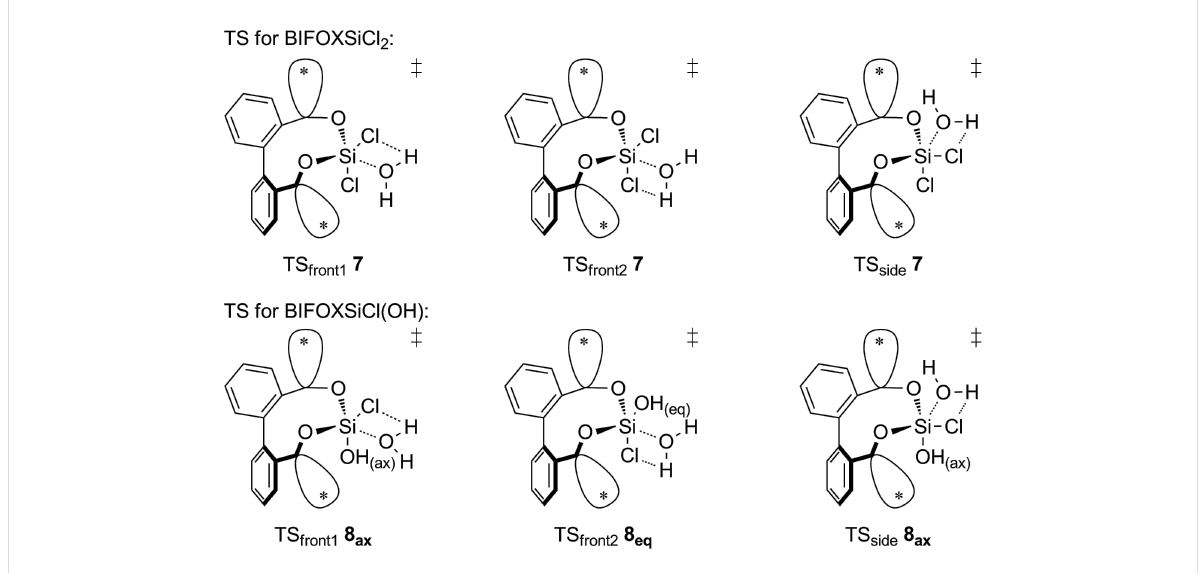
Figure 4: Three transition structures each, for the hydrolysis of BIFOXSiCl 2 ( 7 ) and BIFOXSiCl(OH) ( 8 ) considering two possible configuration isomers of BIFOXSiCl(OH) ( 8 ). For 8 ax the OH group is parallel situated to the biaryl axis. For 8 eq the OH group is orthogonal oriented to the biaryl axis. The fenchyl groups are abbreviated with (*) for more clarity.